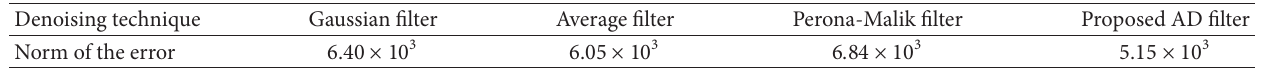
Table 1: Values of norm of the error image parameter for various noise reduction approaches.